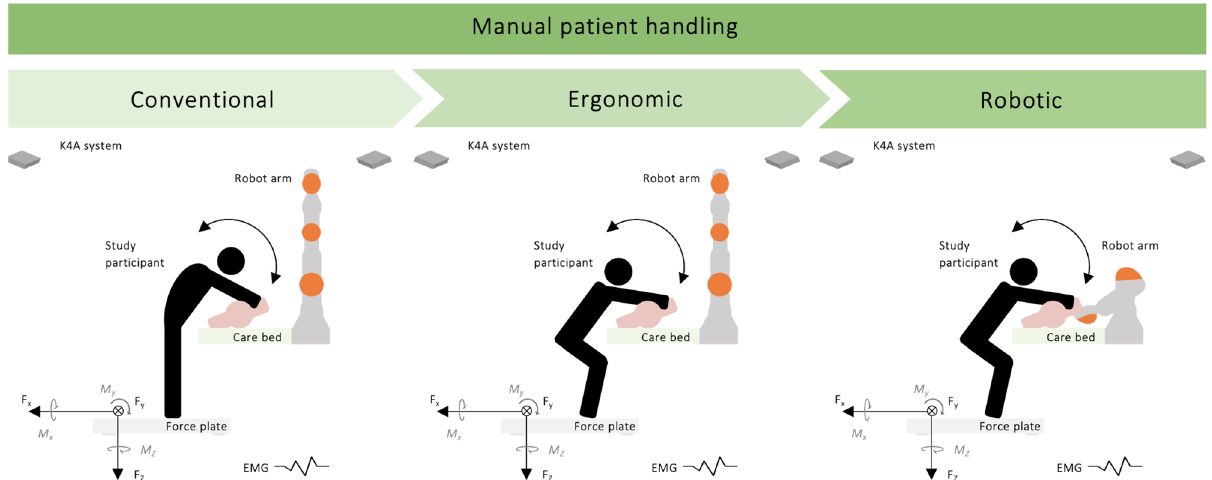
Figure 2. Schematic representation of the experimental design and the manual patient handling tasks, showing the direction of ground reaction forces (F X , F Y , F Z ) and respective force plate moments (M X , M Y , M Z ). In addition, the study participants were equipped with EMG sensors (Fig.